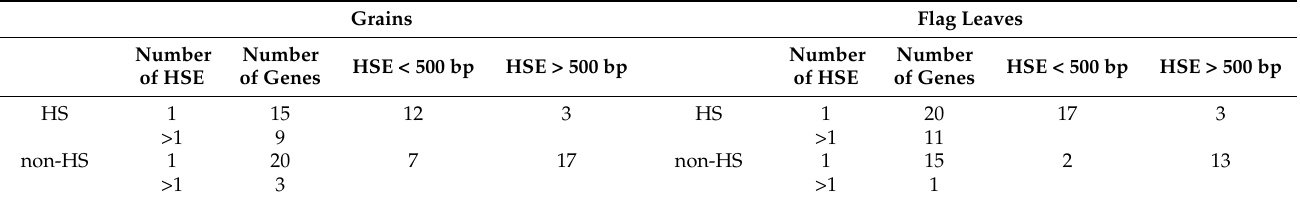
Table 2. Distributions of HSEs in the promoter regions of heat responsive TaHSP70s. Grains Flag